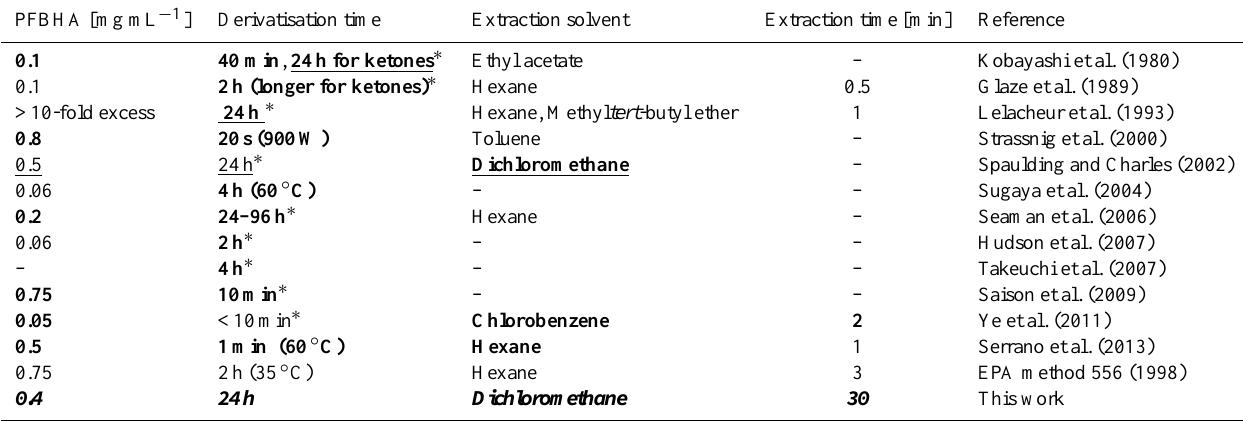
Table 1. Studies reporting the optimisation of a PFBHA method and fulfilling the selection criteria: (i) derivatise carbonyl compounds in the aqueous phase (derivatisation on solid phase, cartridges or on a chip are not compared: Cullere et al. (2004); Nawrocki et al. (1996); Pang et al. (2013), (ii) optimise one of the reaction parameters investigated within this study and (iii) use the same extraction techniques as in the present study (solid phase micro extraction or extraction on fibre are not included, e.g. Cancho et al., 2002). The optimised method parameters are given in bold and the parameters matching with the present study are underlined.